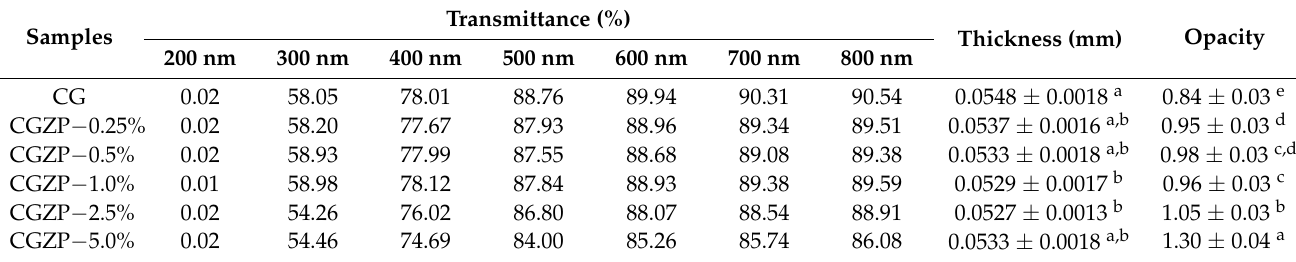
Different superscript letters in the same column demonstrate significant differences between values ( p <